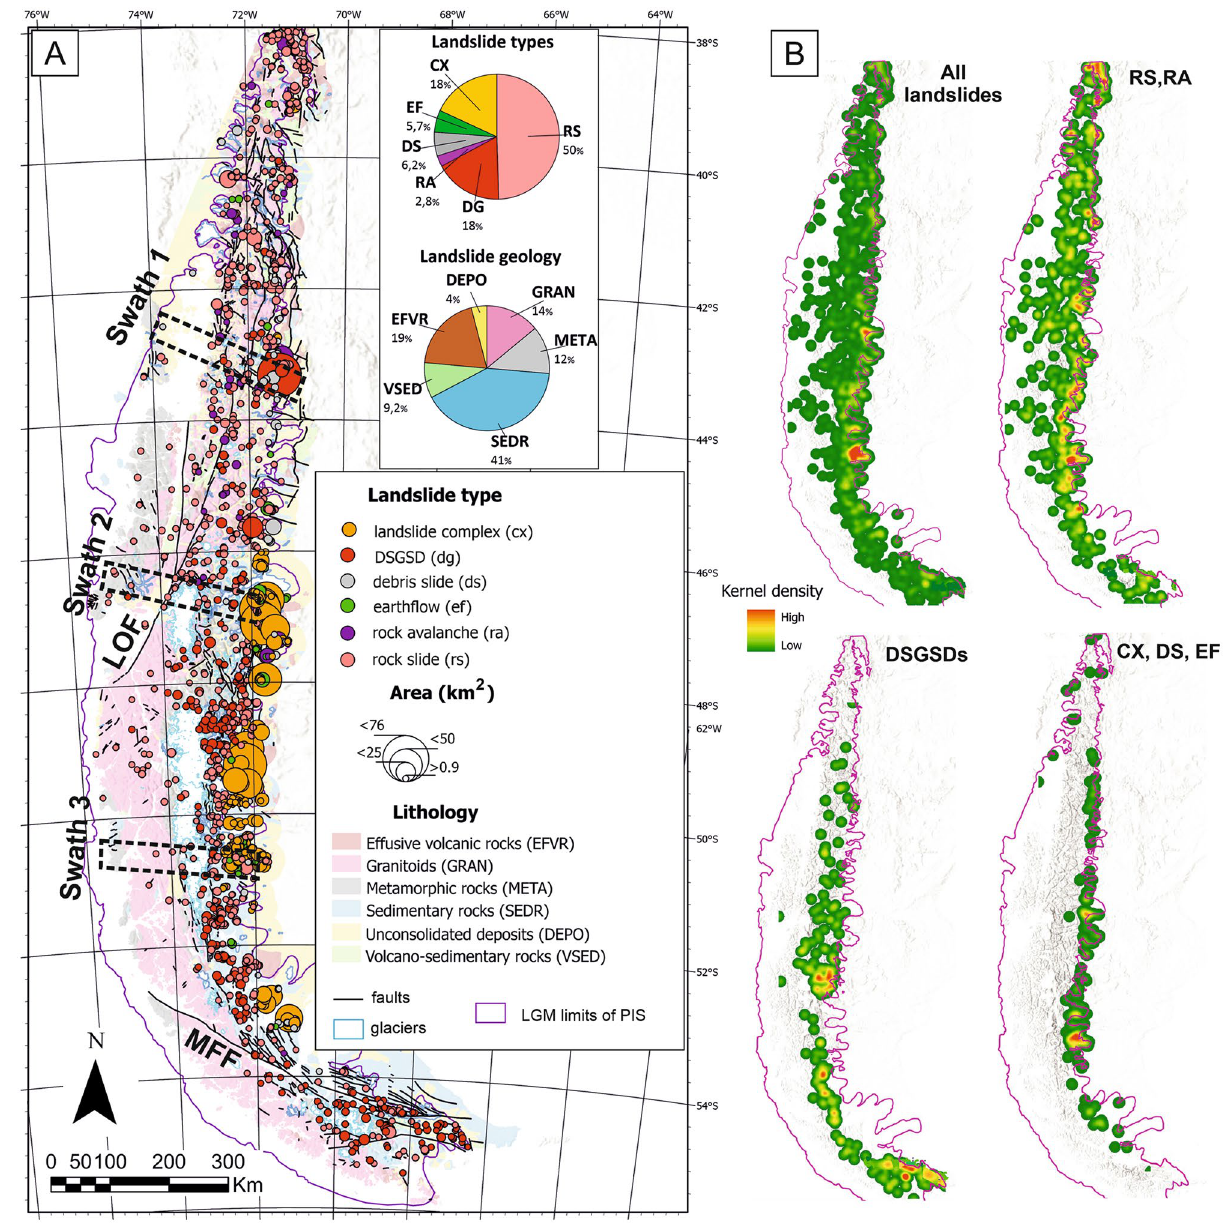
Figure 1. Spatial distribution of large (> 0.9 km 2 ) landslides and geology within the LGM limits of the PIS. ( A ) Landslides area displayed as size-graded centroids with inset pie diagrams showing the proportion of landslide types and their lithology. Geology is from the 1:1,000,000 maps of Chile (SERNAGEOMIN, 2000) and Argentina (SEGEMAR, 1995). ( B ) Kernel density maps for all landslides and their individual types. Major faults: LOF—Liquiñe-Ofqui fault zone, MFF—Magallanes-Fagnano